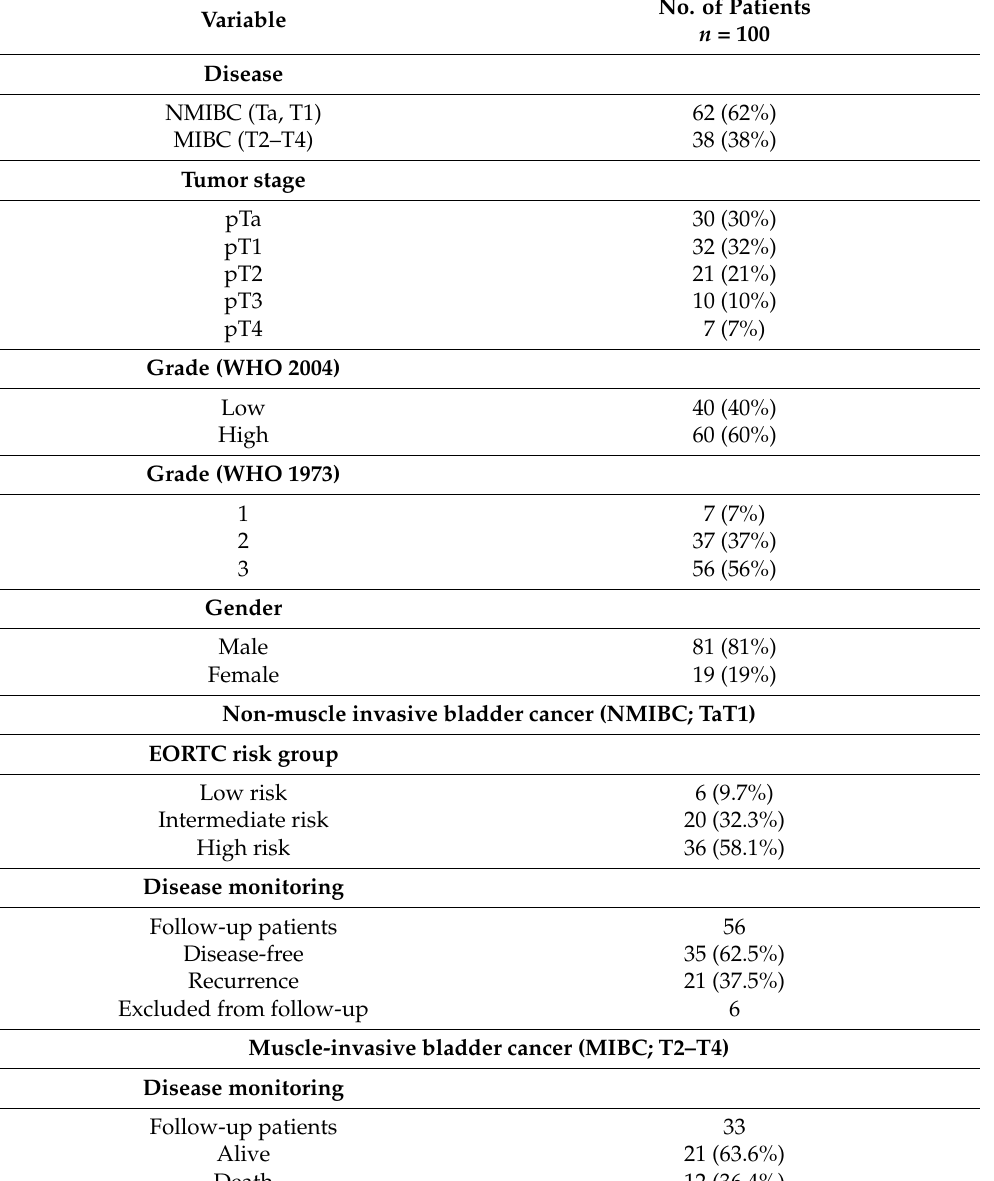
Table 1. Clinicopathological features of the BlCa